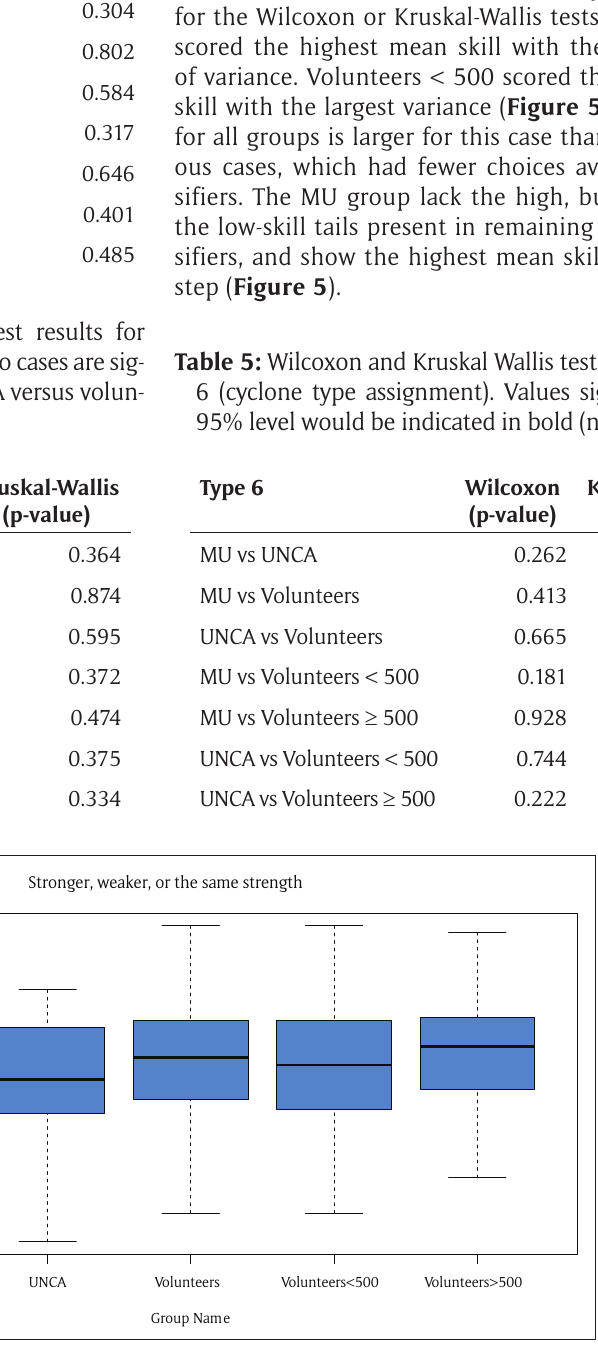
Figure 4: Boxplot of the results for Stronger, Weaker, or the same strength question (n = 3, so trace value bounded between 0 and 3). A trace value of 1 would represent completely random selections by the users and thus a complete lack of skill for this task.